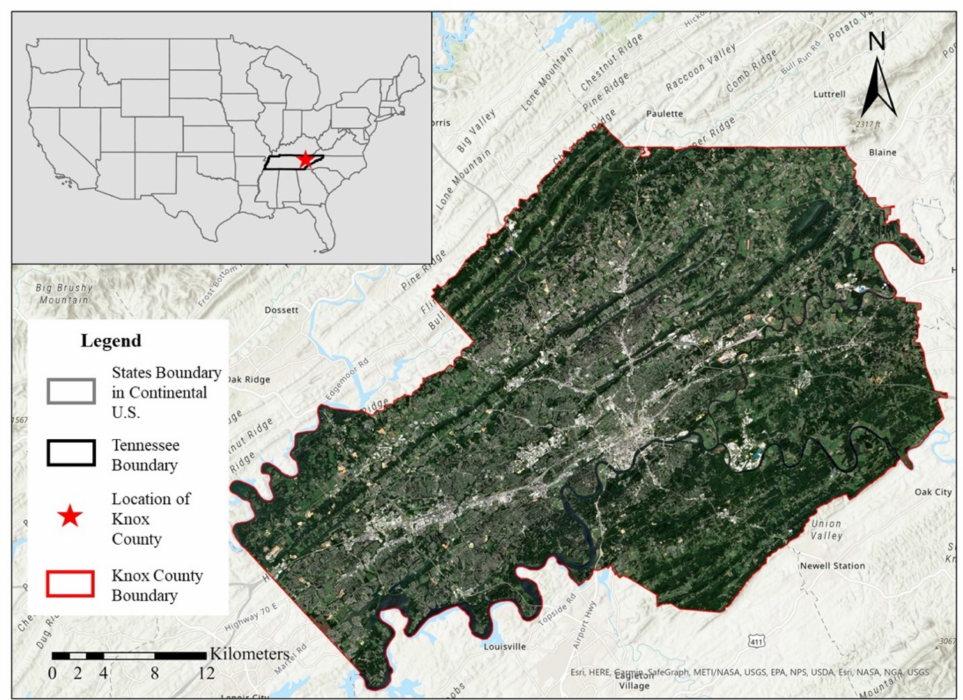
Figure 1. The location of the study area and a true color composite image of Knox County (Sentinel-2 image acquired on 6 September 2020).